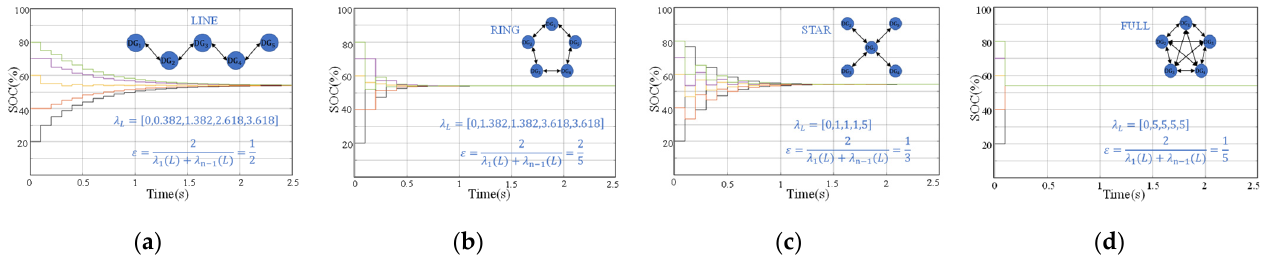
Figure 7. Network dynamics under different topologies. ( a ) Line; ( b ) ring; ( c ) star; ( d ) full.